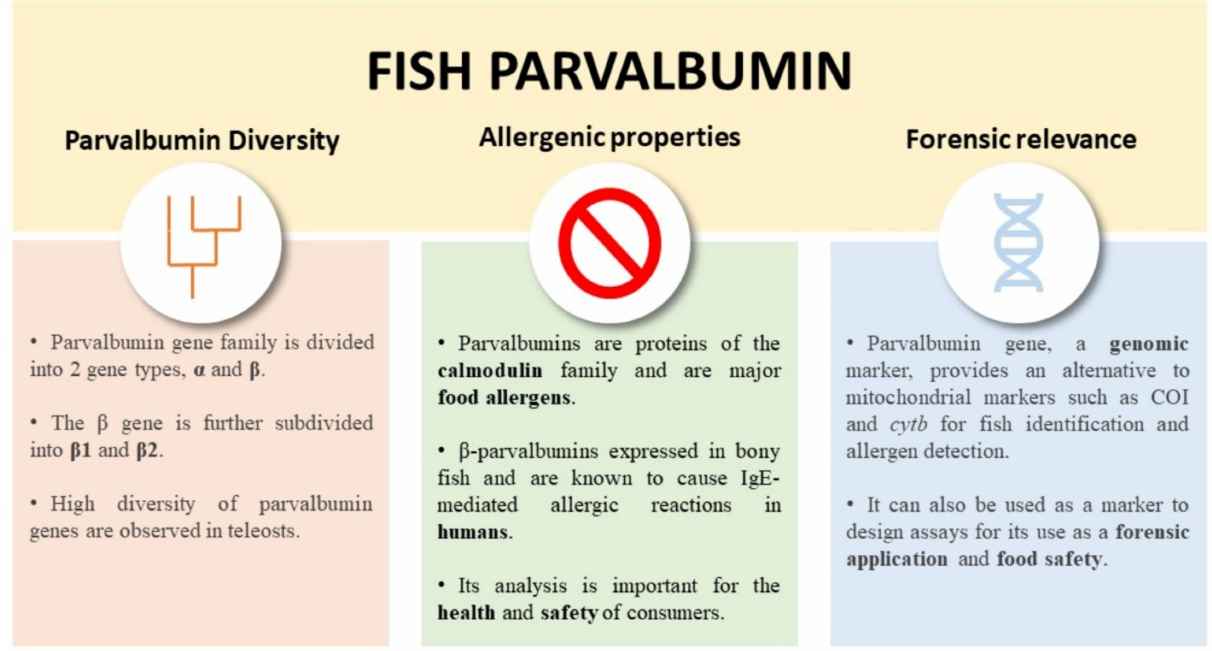
Figure 1. Overview of the importance and applicability of fish